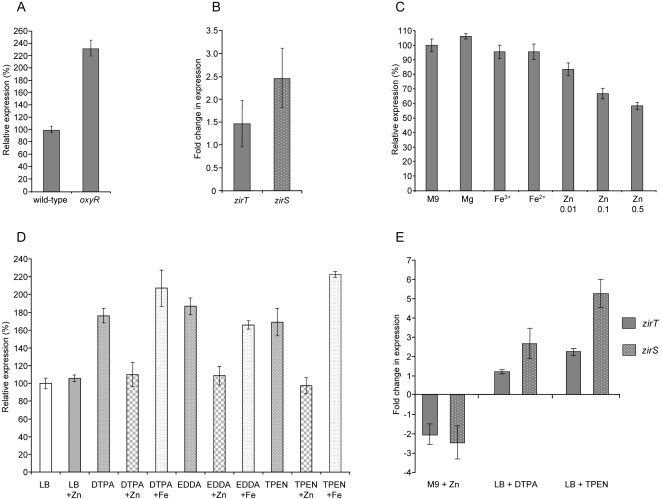
The ZirTS pathway is negatively regulated by zinc and OxyR.A. OxyR negatively regulates the expression of zirTS. Wild-type S. Typhimurium SL1344 (wild-type) and an isogenic strain harboring a mutation in oxyR (oxyR) expressing zirTS::lacZ were grown in M9 minimal medium to late stationary phase. β-galactosidase assay was performed to evaluate the expression of zirTS::lacZ in each strain. The presented values represent the average of at least 7 independent cultures with a standard deviation shown by the error bars. B. Expression of zirT and zirS in the oxyR background vs. the wild-type strain as determined by q-RT-PCR. RNA was harvested from SL1344 and the oxyR mutant strains grown in M9; reverse-transcribed and the expression of zirT and zirS was examined by quantitative real-time PCR. The fold change in the expression of zirT and zirS in the oxyR background, relative to their expression in the wild-type strain is presented. Expression was normalized using the housekeeping rpoD gene as a control. The results represent the average of 4 independent experiments (each included 3–5 replicates) with a standard deviation shown by the error bars. C. Expression of zirTS in the presence of metals. S. Typhimurium SL1344 expressing zirTS::lacZ was grown in M9 medium (M9) or M9 supplemented with the following metal salts: 0.1 mM MgSO4 (Mg), 0.1 mM FeCl3 (Fe3+), 0.1 mM FeSO4 (Fe2+), and ZnSO4 (Zn) in the indicated concentrations (0.01, 0.1, or 0.5 mM). Cultures were grown to a late stationary phase and β-galactosidase assay was performed to evaluate the expression levels of zirTS::lacZ under each condition. The presented values represent the average of at least 8 independent cultures with a standard deviation shown by the error bars. D. Expression in the presence of metal chelators. S. Typhimurium SL1344 expressing zirTS::lacZ was grown in LB broth (LB) or LB supplemented with the following compounds: 1 mM ZnSO4 (LB+Zn), 0.1 mM metal chelators (DTPA, EDDA, or TPEN), metals chelators with 1 mM ZnSO4 (Zn), or metal chelators with 1 mM FeSO4 (Fe). Cultures were grown to a late stationary phase following by β-galactosidase assay. The presented values represent the average of at least 8 independent cultures with a standard deviation shown by the error bars. E. Expression of zirT and zirS in the presence and absence of zinc and metal chelators as determined by q-RT-PCR. RNA was harvested from wild-type Salmonella cultures that were grown either in M9 medium in the presence or absence of 0.5 mM ZnSO4; or in LB supplemented with or lacking DTPA (0.1 mM) or TPEN (0.05 mM). RNA was reverse-transcribed and the expression of zirT and zirS was examined by real-time PCR. The fold change in the expression of zirT and zirS in cultures that were grown in the presence of zinc (M9+Zn) or metal chelators (LB+DTPA/TPEN) relative to their expression in the appropriate unsupplemented media is presented. Expression was normalized using the housekeeping rpoD gene as a control. The results represent the average of 3 independent experiments (each included 3–5 replicates) with a standard deviation shown by the error bars.